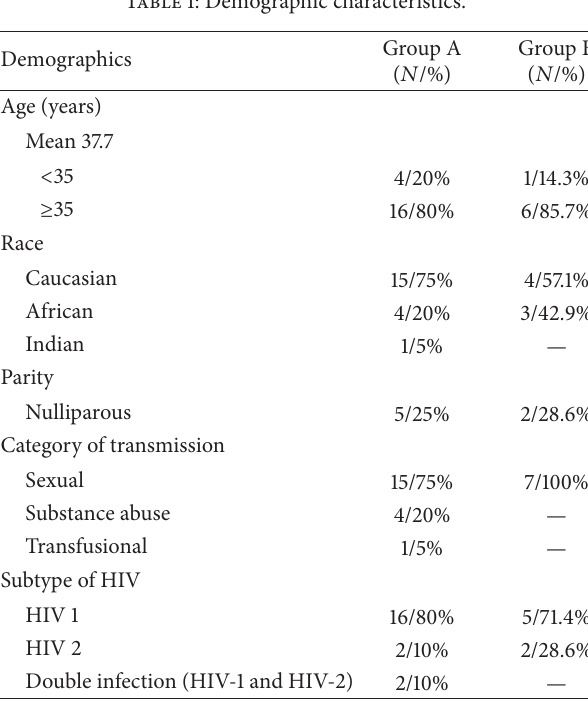
Table 1: Demographic